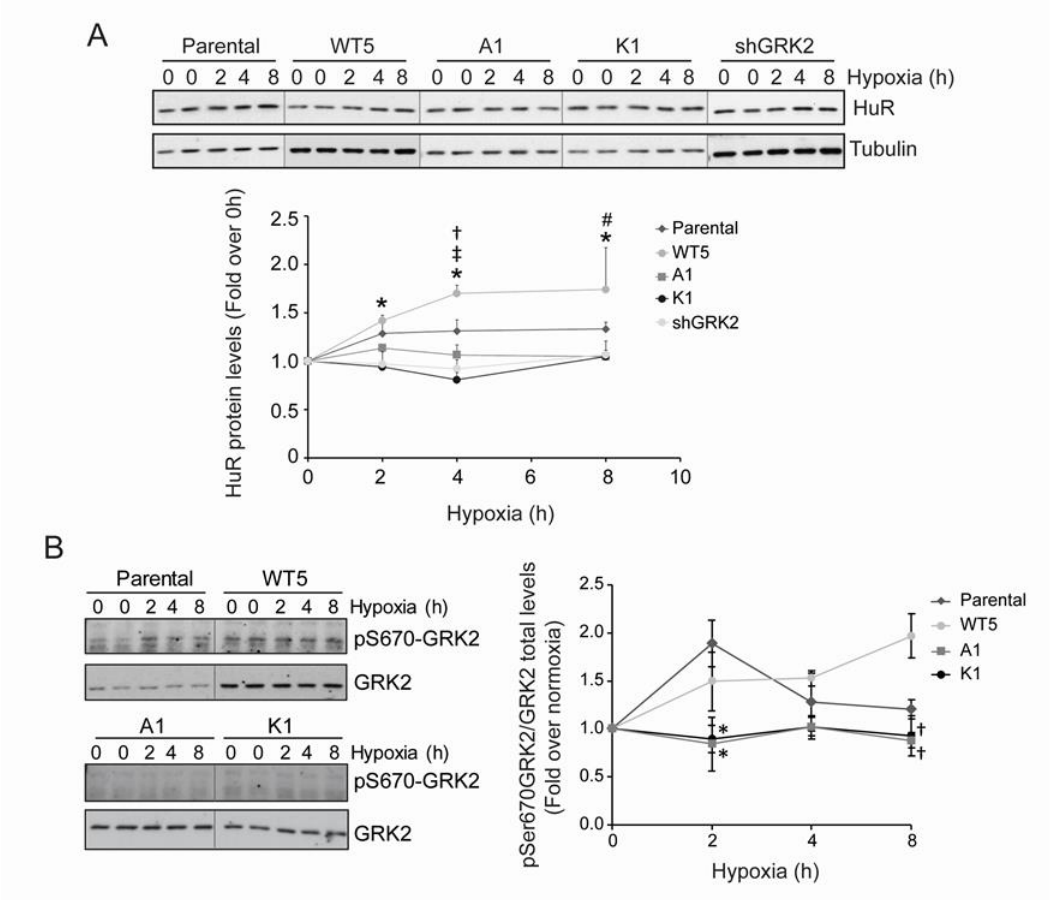
Figure 2. pS670-GRK2 modulates hypoxia-induced HuR upregulation. ( A , B ) HeLa stable cell lines were cultured under hypoxia and the pSer670 GRK2, GRK2, and HuR levels were analyzed by immunoblotting, at the indicated times. Values are mean ± SEM from 4–6 independent experiments. Upper panel: ‡ p < 0.05 wt5 vs. parental; # p < 0.05 A1 vs. parental; * p < 0.05 K1 vs. parental; † p < 0.05 shGRK2 vs. parental (Student’s t -test). Lower panel: * p < 0.05 A1 and K1 vs. parental; † p < 0.05 A1 and K1 vs. WT5 (Student’s t -test). Detailed information about the Western blots can be found in Figure S4.